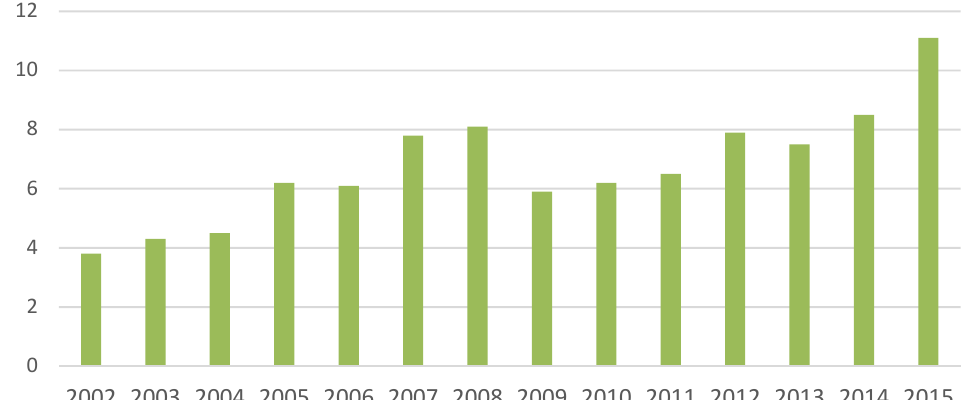
Figure 5. The number of logistics, transport, and shipping companies in Poland operating both in the domestic and international markets. (Source: P. Szuster, 2015, Logistics Operator of the Year 2015, Eurologistics No 91, page 21.).